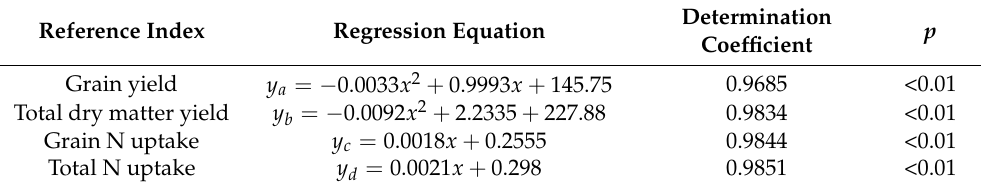
Table 7. Maize grain yield, total dry matter yield, grain P uptake and total P uptake in response to the mineral P application rate.